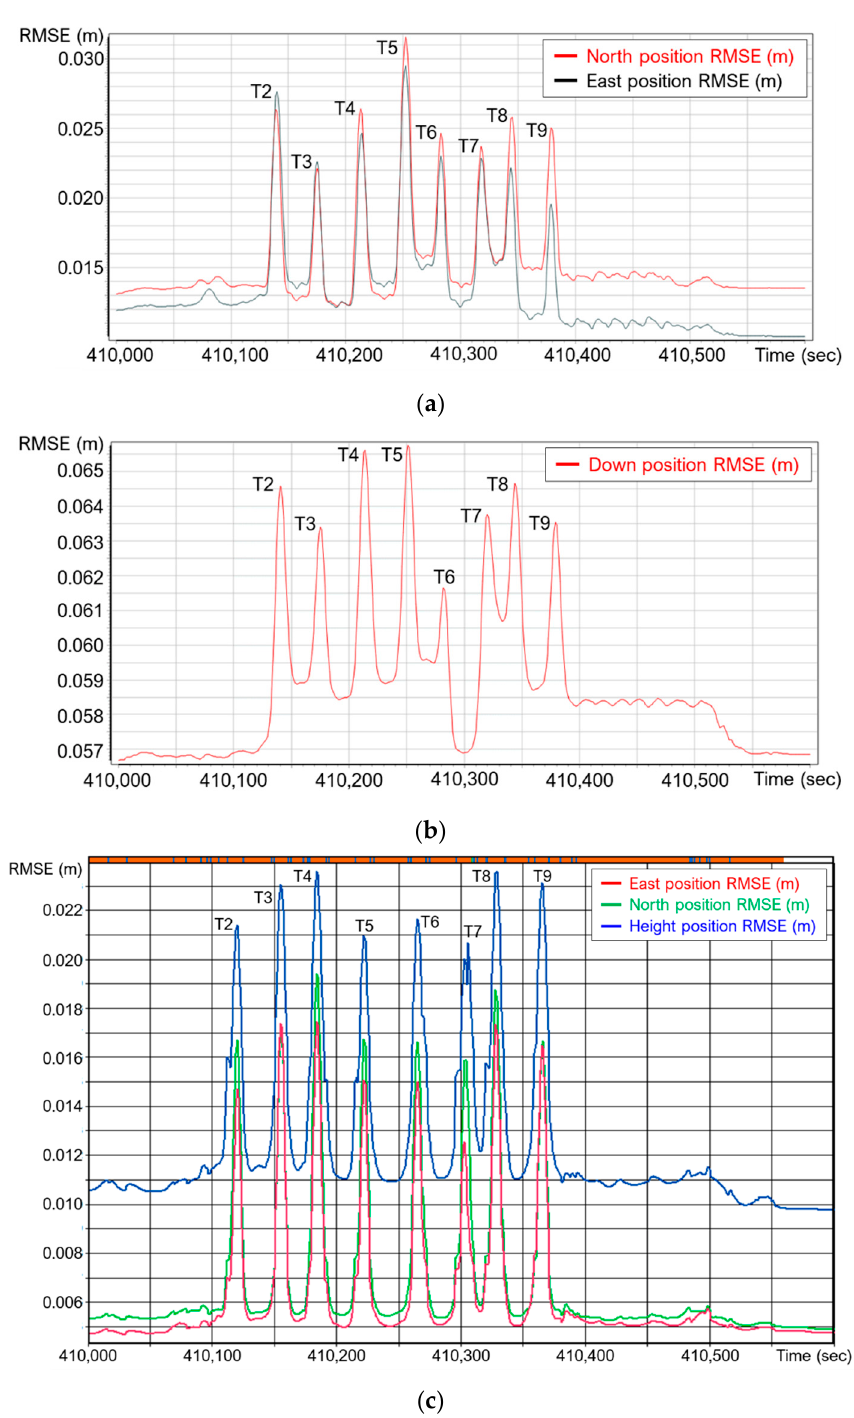
Figure 4. Global navigation satellite system/inertial navigation system (GNSS/INS) position accu- racy charts for the ( a ) PWMMS-HA (north and east positions), ( b ) PWMMS-HA (down position), and ( c ) PWMMS-UHA vehicles. The highlighted eight peaks correspond to the eight southbound and northbound tracks (Tracks T2–T9) on the US-231 below the bridge, where suboptimal position accuracy can be observed.